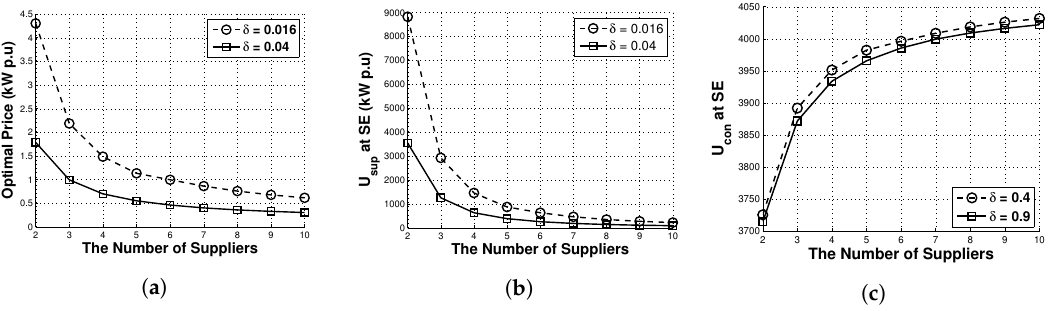
Figure 5. ( a ) Optimal price, ( b ) utility of the supplier, and ( c ) net utility of consumers at the Stackelberg equilibrium (SE) as the number of suppliers